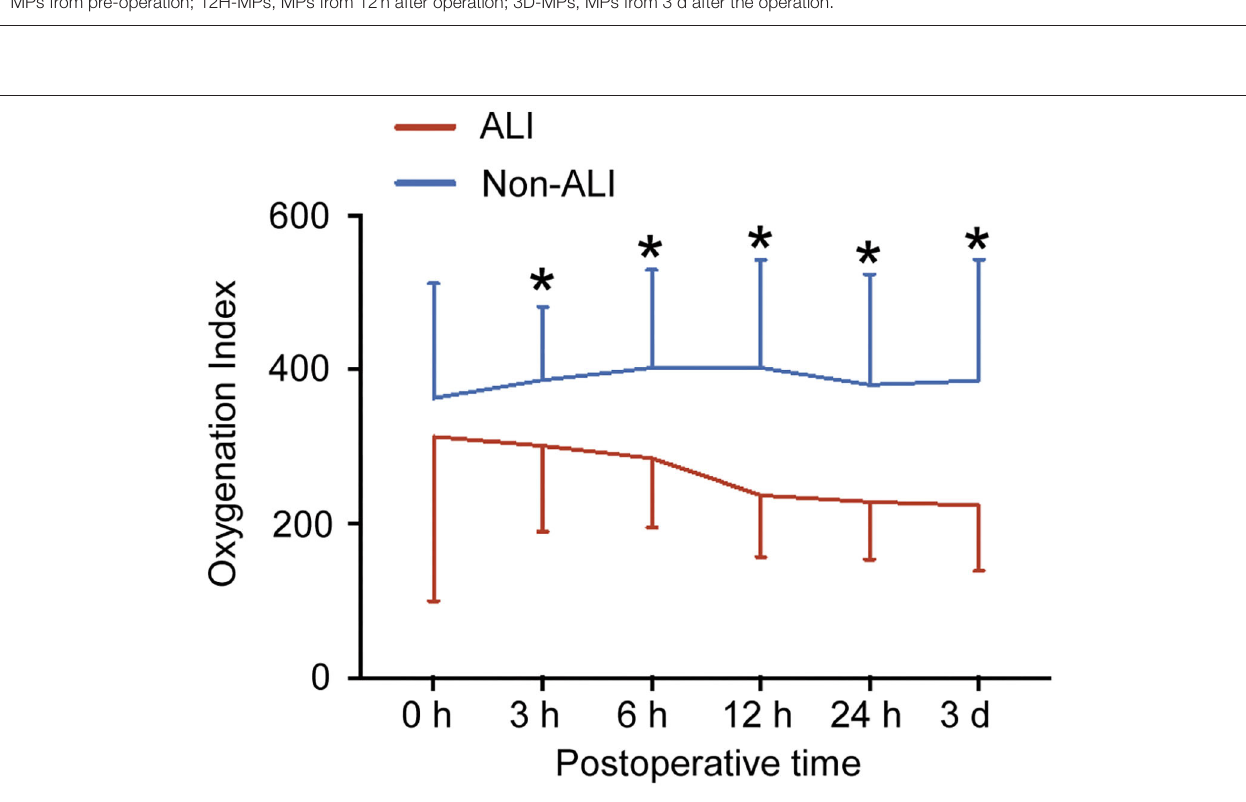
FIGURE 3 | Postoperative oxygenation index (OI) between the ALI and non-ALI groups. The figure showed the OI in patients with and without ALI at different times after surgery. *, vs. ALI group at the same time point, P <